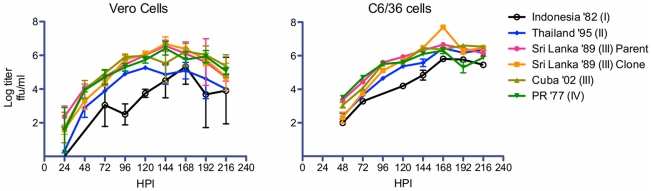
Recombinant dengue virus growth kinetics in tissue culture.Vero (figure 3A) and C6/36 (figure 3B) cells were inoculated at a multiplicity of infection (m.o.i) of 0.01 FFU. Cell culture supernatants were harvested at indicated times and the virus released from the infected cells was quantitated by immunofocus assay. Points show geometric mean titer (GMT) calculated from triplicate titrations. Error bars indicate 95% confidence intervals for each GMT. For Vero cells no focus forming units were observed at 0 hrs and for C6/36 cells no focus forming units were observed at 0 hrs and 24 hrs.